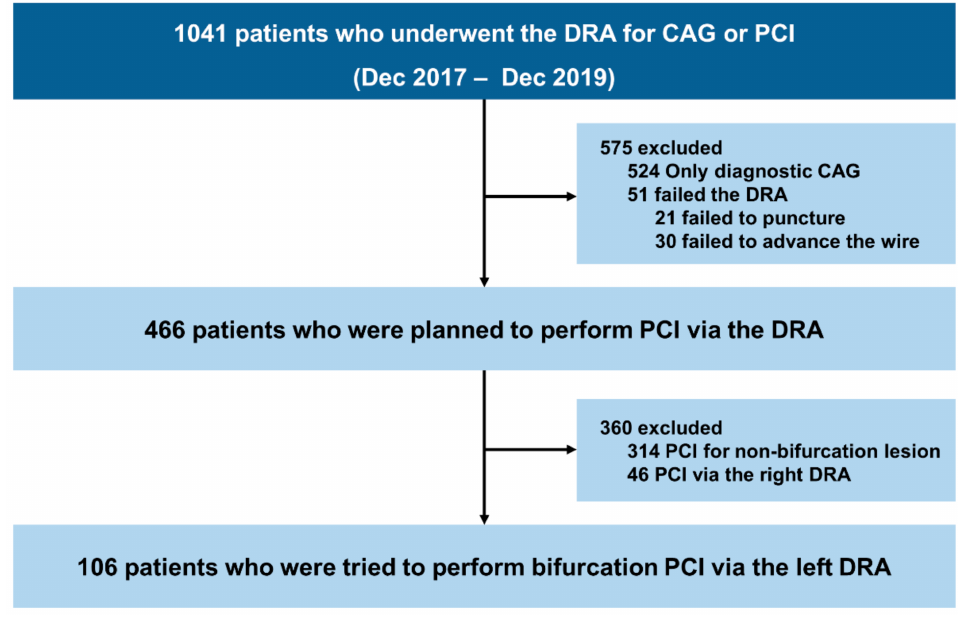
Figure 1. Study flowchart. Abbreviations: CAG, coronary artery angiography; DRA, distal radial approach; PCI, percutaneous coronary